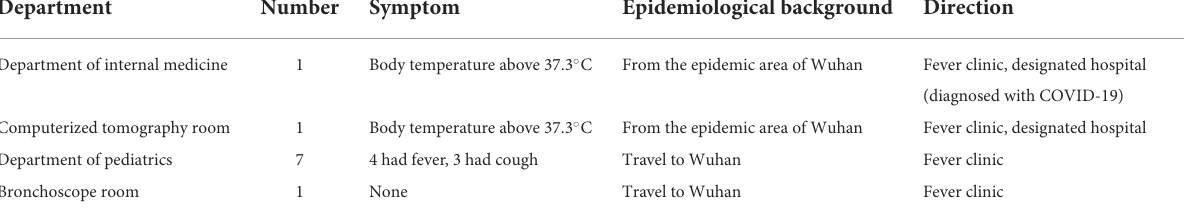
TABLE 2 Patients with a history of traveling to Wuhan or coming from the epidemic area of